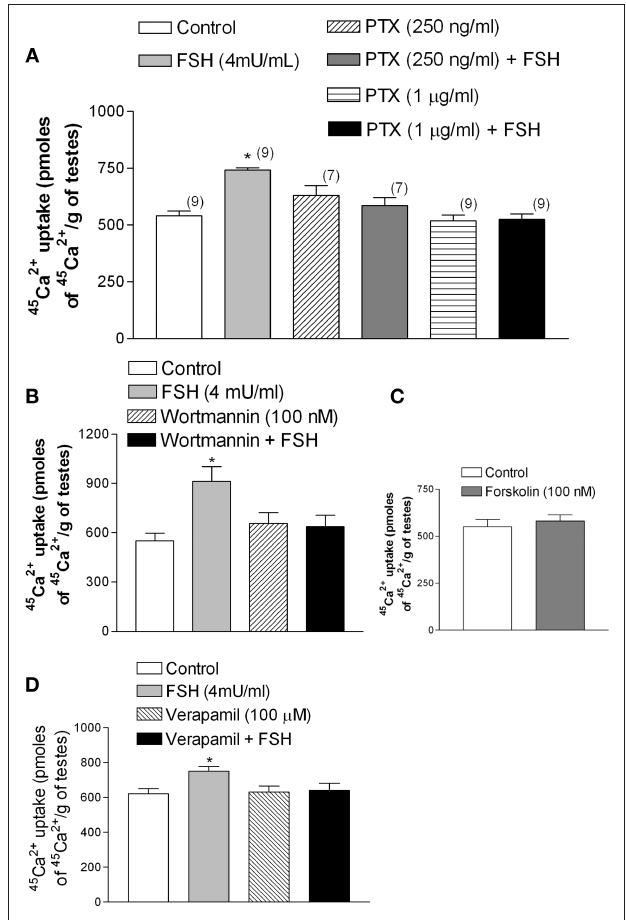
FiGure 4 | Follicle stimulating hormone produces an increase in 45 Ca 2 + uptake within 2 min of incubation. This increase was inhibited by PTX (A) , wortmannin (B) , and verapamil (D) . Forskolin was not able to increase 45 Ca 2 + in 2 min (C) . (A) * p < 0.05, as compared with the other groups, n in brackets from two separated experiments; (B,D) * p < 0.05, as compared with the other groups, n = 5 from one experiment.